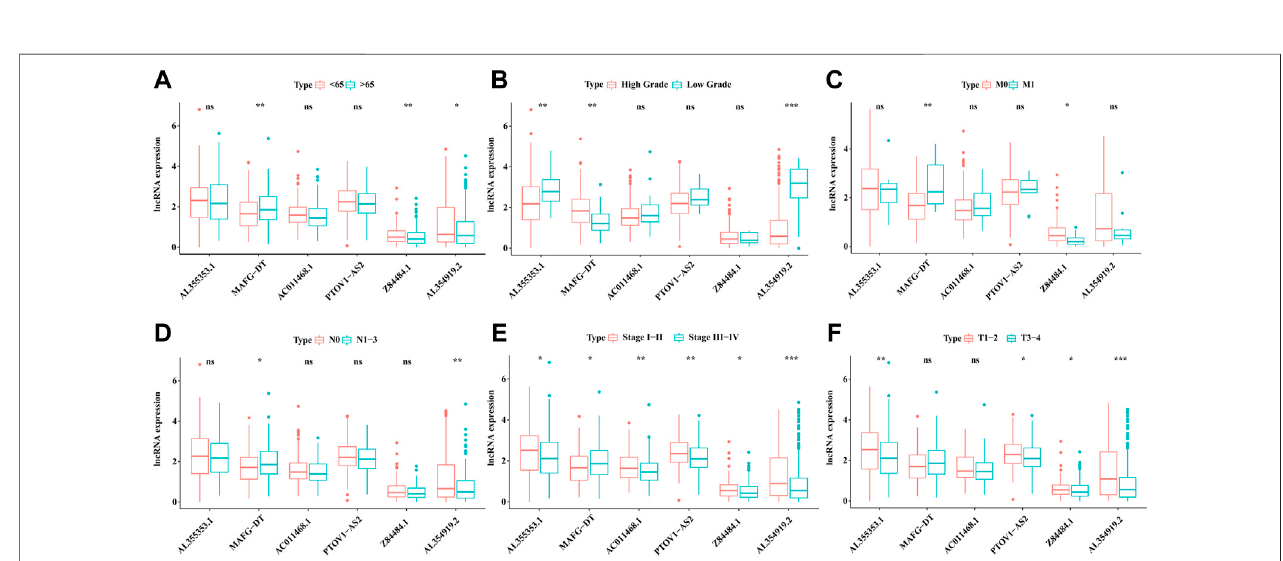
FIGURE8| Theassociationof6glyco-lncRNAswithclinicalcharacters.Therelationofthe6glyco-lncRNAswithage (A) ,tumorgrade (B) ,distantmetastasisstatus (C) , lymphatic metastasis status (D) , UICC stage (E) , and T stage (F) .